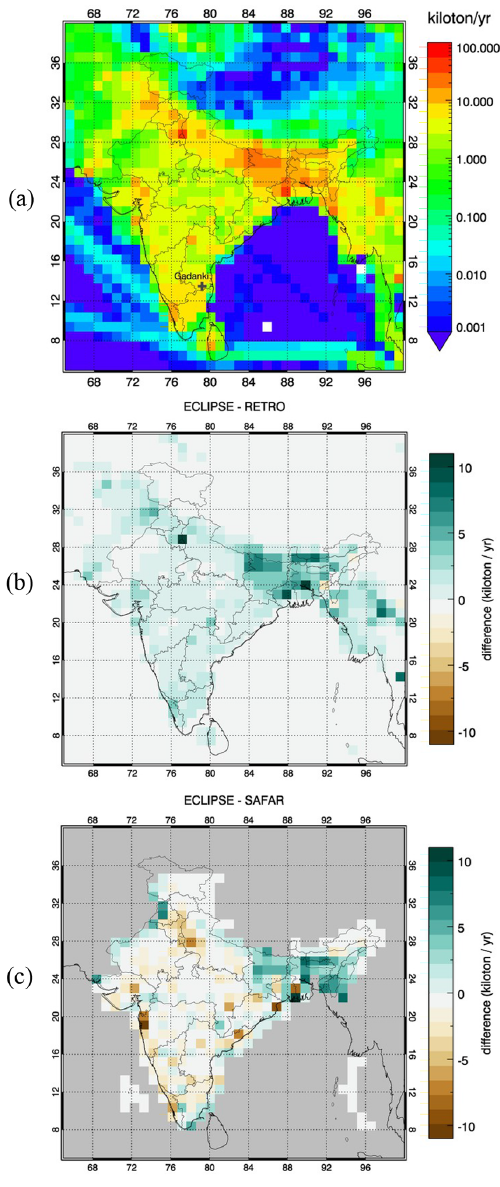
Figure 3. (a) ECLIPSE (ECLIPSE v5 + GFED v3) BC emission in- ventory over South Asia. (b) Difference between the ECLIPSE and RETRO emissions (ECLIPSE – RETRO). (c) Difference between ECLIPSE and SAFAR India emissions (ECLIPSE – SAFAR). Here and in rest of the paper political borders are shown for cursory re- gion identification and may not be